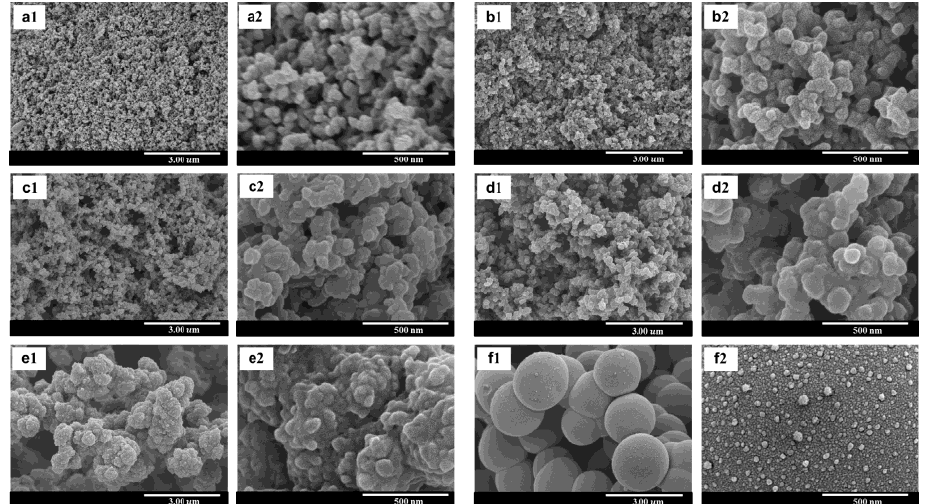
Figure 24. SEM images with low magnification ( 1 ) or high magnification ( 2 ) of Synperonic NP30 added at concentrations of ( a ) 0 M, ( b ) 0.003 M, ( c ) 0.009 M, ( d ) 0.030 M, ( e ) 0.090 M, and ( f ) and 0.180 M (reproduced from the work in [36] with permission).